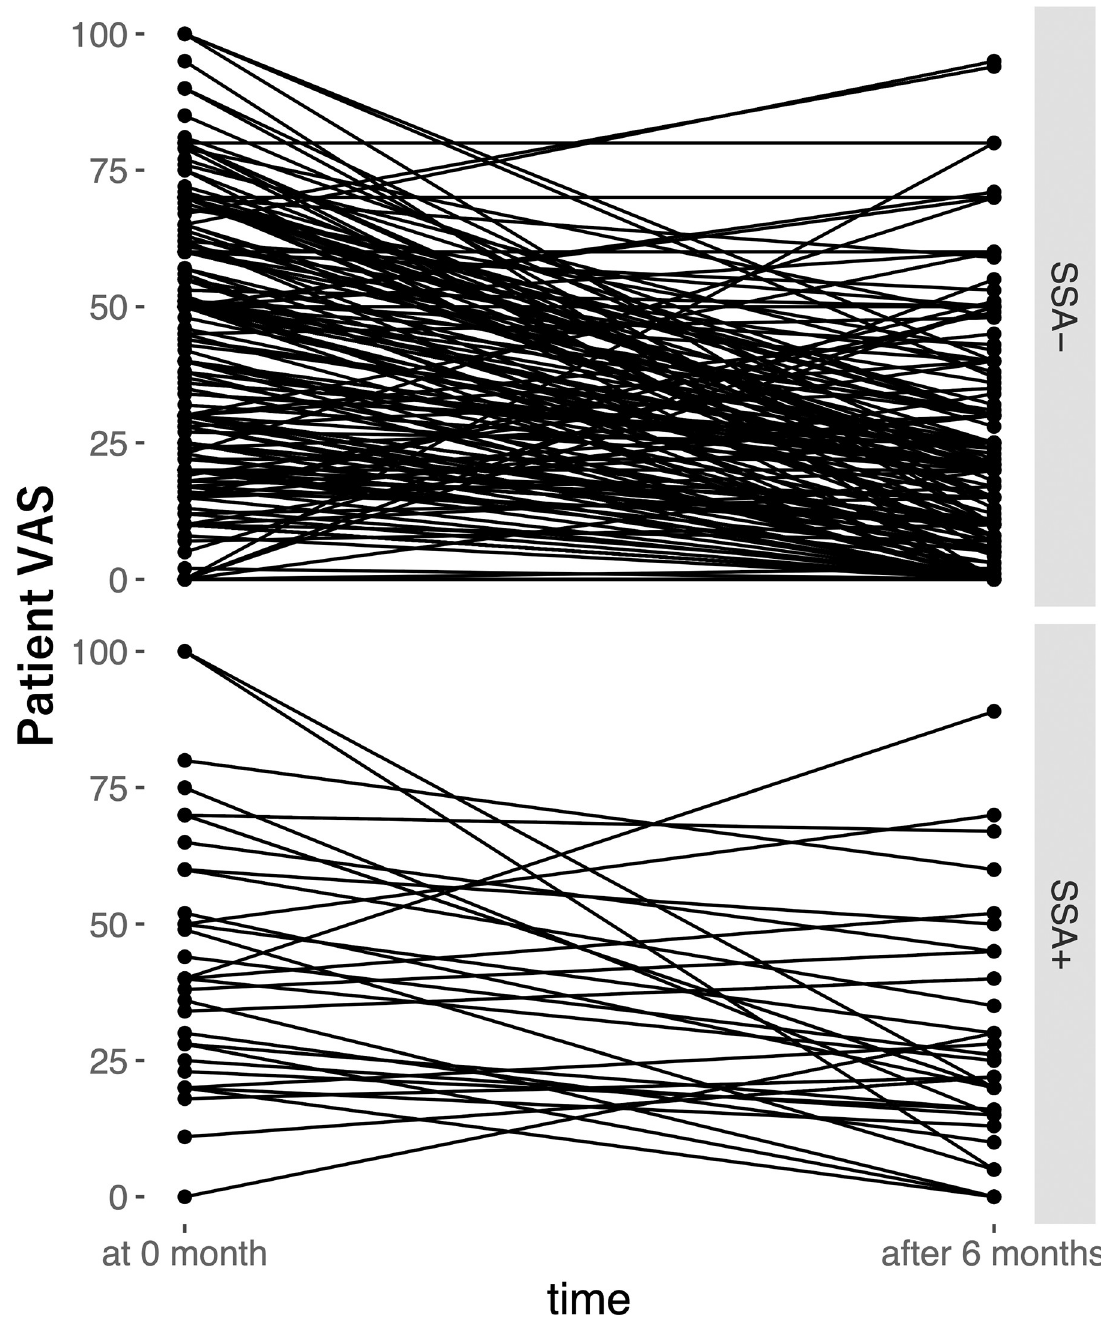
Fig 2. Changing patient VAS score before and 6 months after MTX administration for each